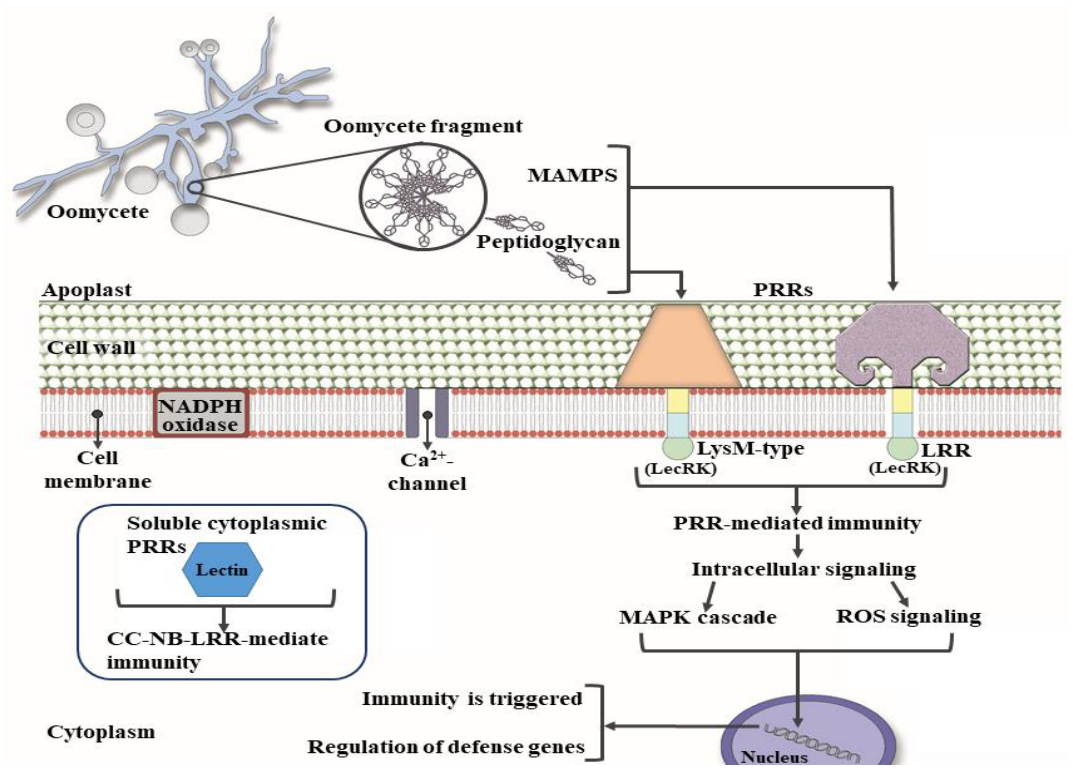
Figure 2. Recognition of effectors in plants by pattern-recognition receptor (PRR) lectins. Once the plant perceives the peptidoglycans (MAMPs) through PRRs with a lectin domain (LecRK and lectin-type lectin-kinase receptor), an intracellular signaling cascade is generated downstream, which leads to protein phosphorylation, generation of reactive oxygen species (ROS), regulation of phytohormones, activation of transcription factors due to what is known as microorganism-/pathogen-triggered immunity (M/PTI) or, when soluble receptors recognize effectors from the pathogen, the generation of effector-triggered immunity (ETI).